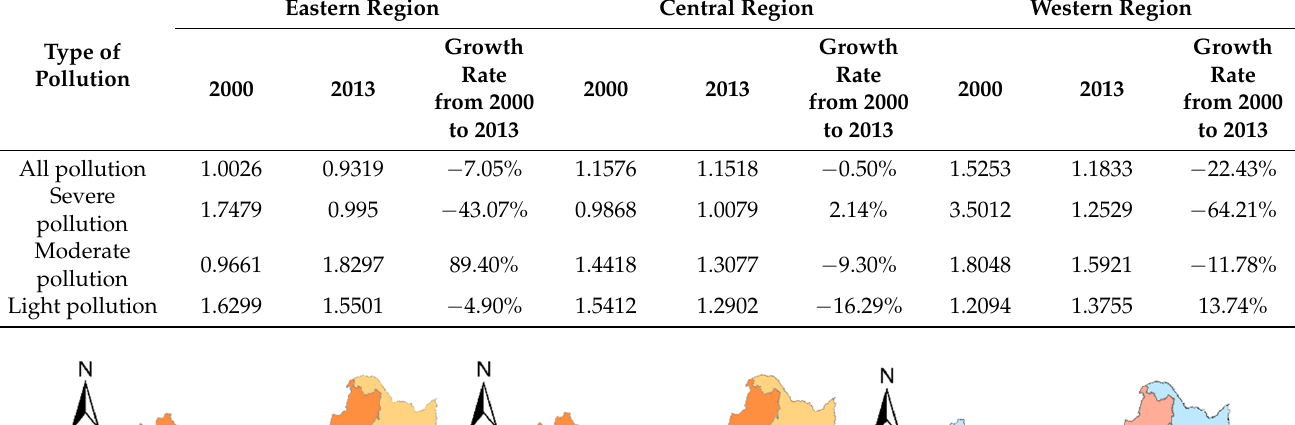
Table 5. Regional differences in transboundary pollution effects.